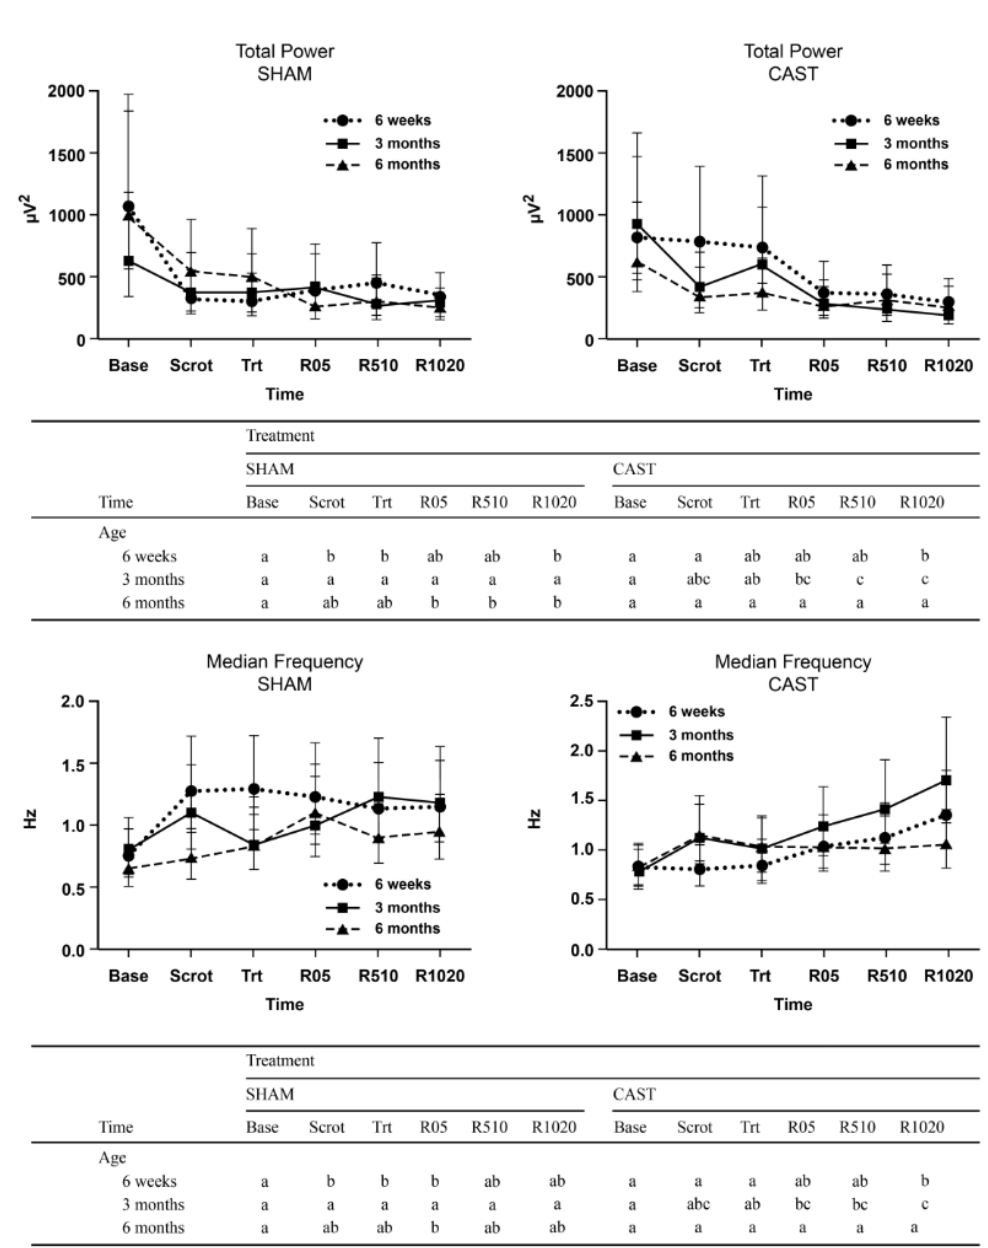
Figure 4. Estimated least-square means and 95% confidence intervals of total power ( µ V 2 ) and median frequency (Hz) for 6-week—(6W), 3-month—(3M) and 6-month-old—(6M) calves undergoing simulated castration (SHAM) and surgical castration (CAST) treatments. Time points evaluated consist of baseline (Base), scrotum manipulation (Scrot), treatment (Trt), immediate recovery (R05), middle recovery (R510), and late recovery (R1020). The letters (a, b, c) indicate a significant difference ( p < 0.05) between time points within each age category.